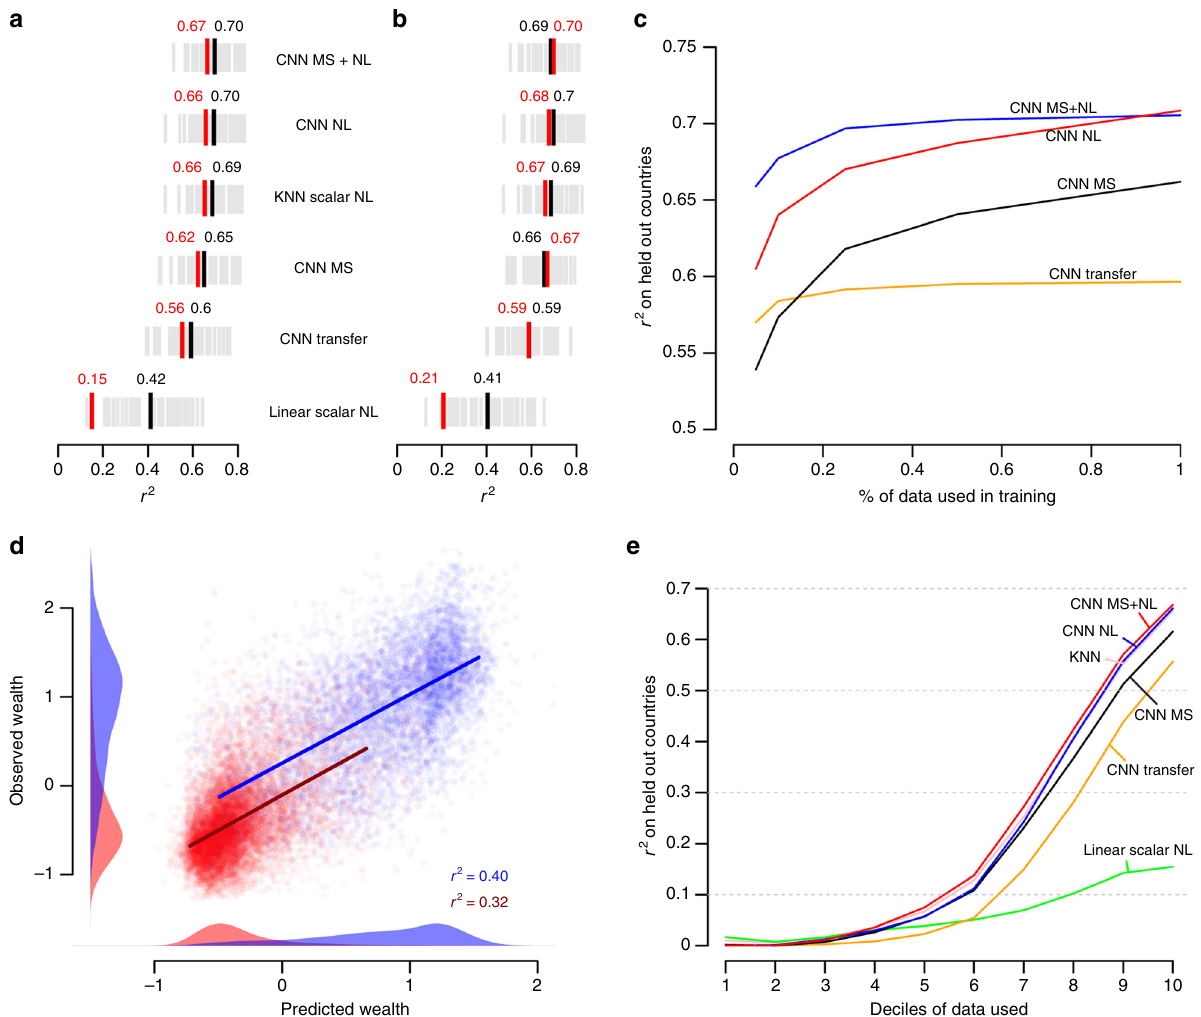
Fig. 3 Performance by model and across different samples. a Predictive performance of satellite predictions trained using 5 different machine learning models; NL nightlights, MS Landsat multispectral, and transfer transfer learning on nightlights with RGB Landsat imagery. Each grey line indicates the performance ( r 2 ) on a held-out country-year, black lines and text show the average across country-years, and red lines and text show the r 2 on the pooled sample. b As in a but for evaluation on held-out villages within the same country. c Performance by amount of training data used. d Performance of CNN MS + NL model in urban versus rural regions in held-out countries. Model is trained on all data in training set and then applied separately to either urban or rural clusters in held-out countries. Each dot is an urban (blue) or rural (red) cluster, with densities showing the distribution of predicted ( x -axis) and ground-measured (y-axis) wealth index. e Performance across the wealth distribution. Experiments were run separately for increasing percentages of the available clusters (e.g., x -axis value of 4 indicates that all clusters below 40th percentile in wealth were included in the test